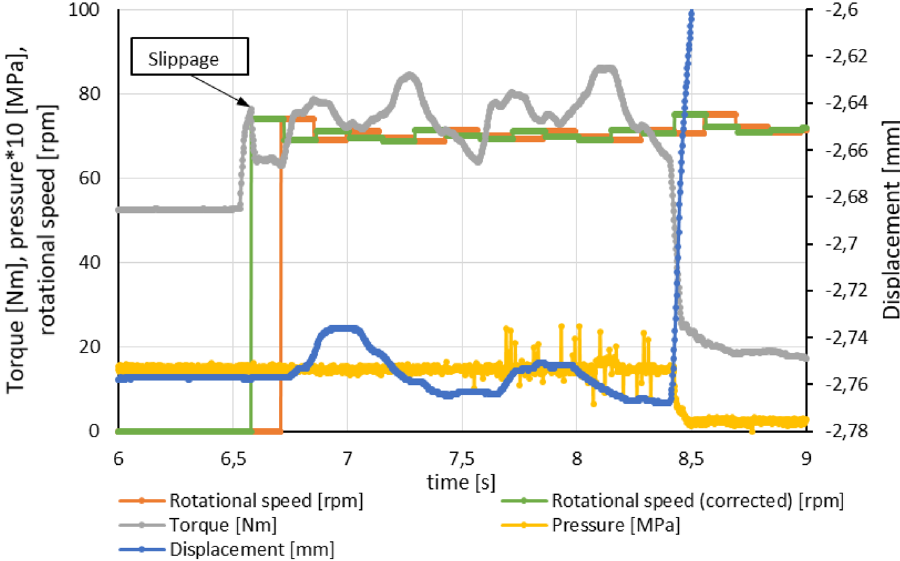
Figure 16. Recorded data of rotational speed, torque, pressure in actuator chamber and displacement presenting decreased displacement of discs package after clutch